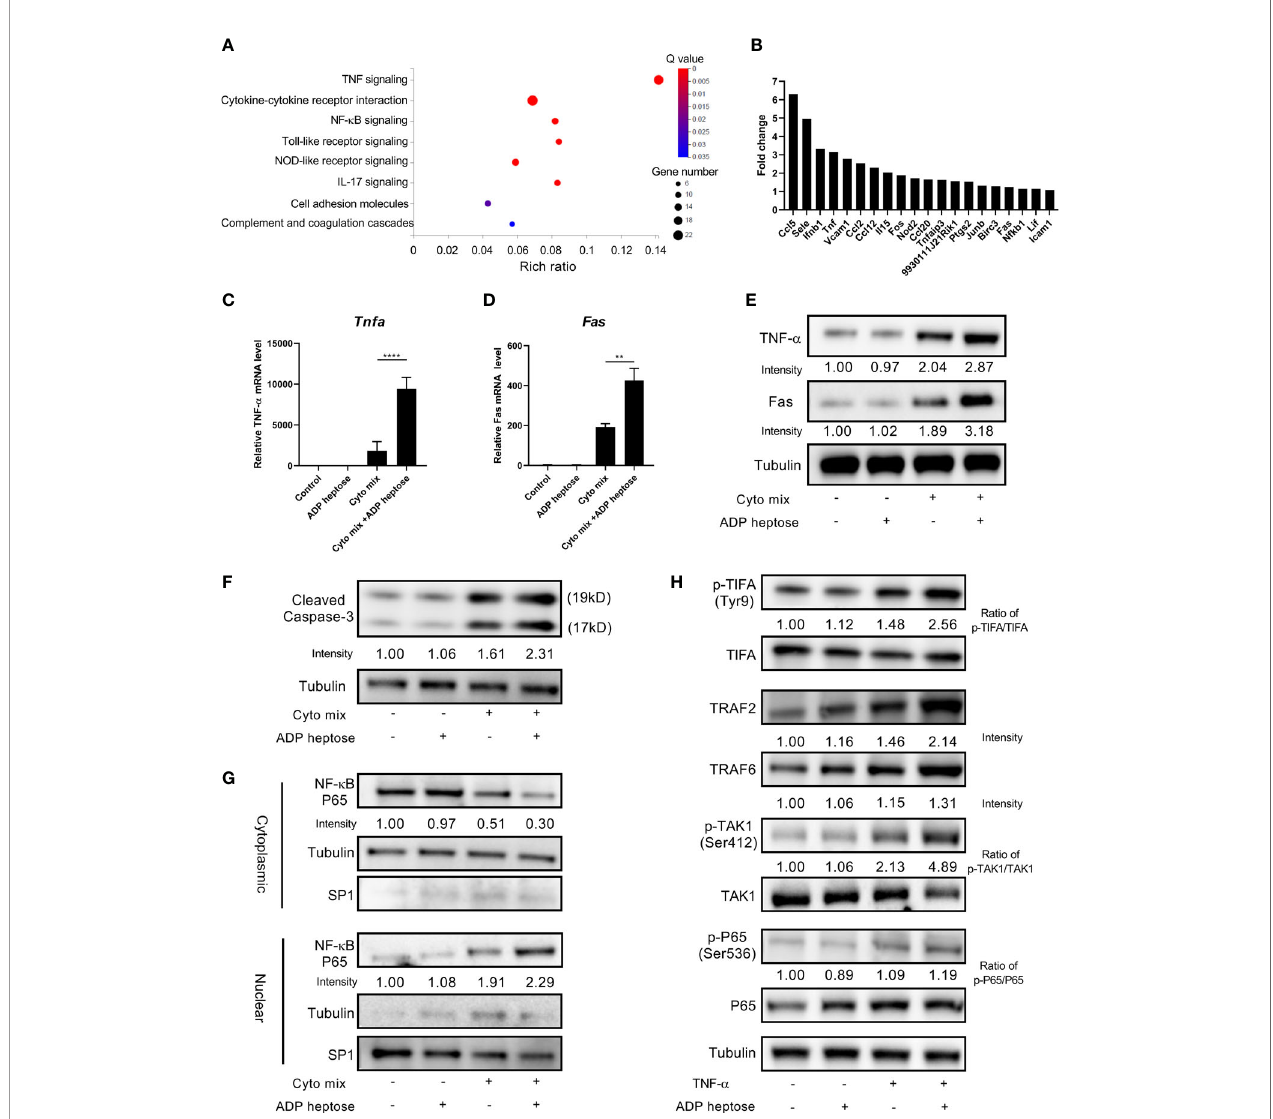
FIGURE 4 | ADP-heptose-induced ALPK1 activation enhanced TNF- a signaling pathways in cytokine-treated beta cells. MIN6 cells were treated with cyto mix or cyto mix plus ADP heptose for 24 hours. RNA from treated cells were extracted and sequenced. (A) Bubble chart showing the signi fi cantly enriched KEGG pathways for differentially expressed genes in MIN6 cells simultaneously treated with cyto mix and ADP heptose (Q value < 0.05). The size of the bubble represents the number of genes annotated to KEGG Pathway. The color represents the enriched signi fi cance. The redder the color, the smaller the signi fi cance value. (B) The expression fold change of twenty differentially expressed genes in enriched TNF- a signaling pathway. MIN6 cells were treated with vehicle, or ADP heptose (32 µM), or cyto mix, or cyto mix plus ADP heptose (32 µM) for 24 hours. TNF- a (C) and Fas (D) mRNA level was measured by qRT-PCR. (E) TNF- a and Fas protein levels were examined by western blotting. (F) The level of cleaved Caspase-3 was examined by western blotting. (G) The nuclear proteins of MIN6 cells were fractioned by subcellular protein fractionation kit for cultured cells (Thermo Scienti fi c, #78840). The levels of cytoplasmic and nuclear NF- k B P65 were detected by western blotting. The cytoplasmic protein Tubulin and nuclear protein SP1 were served as the internal control. (H) MIN6 cells were treated with 10 ng/ml TNF- a , and or 32 µM ADP heptose for 4 hours. Cells were then lysed in lysis buffer containing phosphatase and proteinase inhibitors. Data show mean ± SD and are pooled from 3 independent experiments. The data shown in (C, D) were analyzed with unpaired Student ’ s t-test. **P < 0.01; ****P <